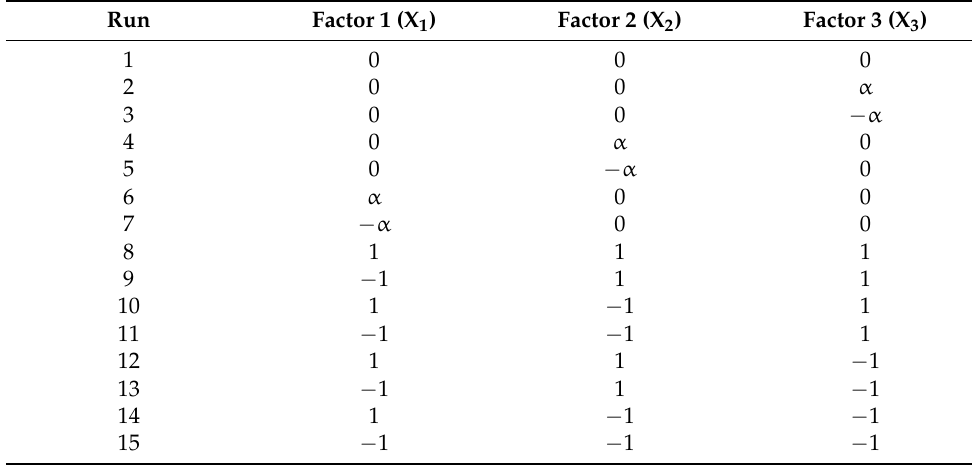
Table 3. Three factor CCD matrix, with one central